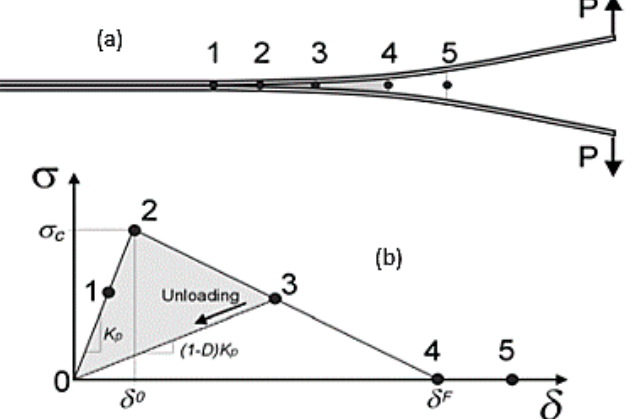
Figure 16. Bilinear traction-separation law for mode I crack in tension [55].